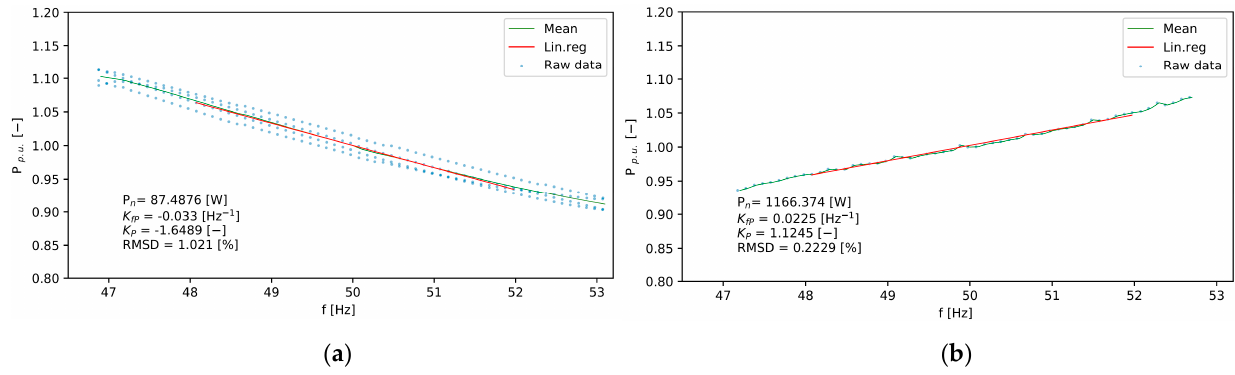
Figure 3. Example of the analyzed result of static load characteristic of ( a ) high-pressure sodium Lamp (70 W); ( b ) microwave with grill (1050 W)